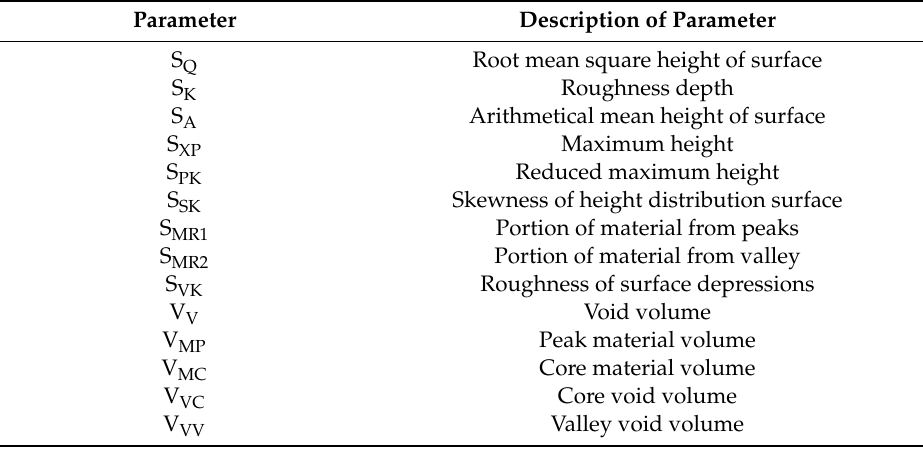
Table 1. 3D (S-parameters) and functional (volume) parameters according to ISO 25178 used to characterize nail surface